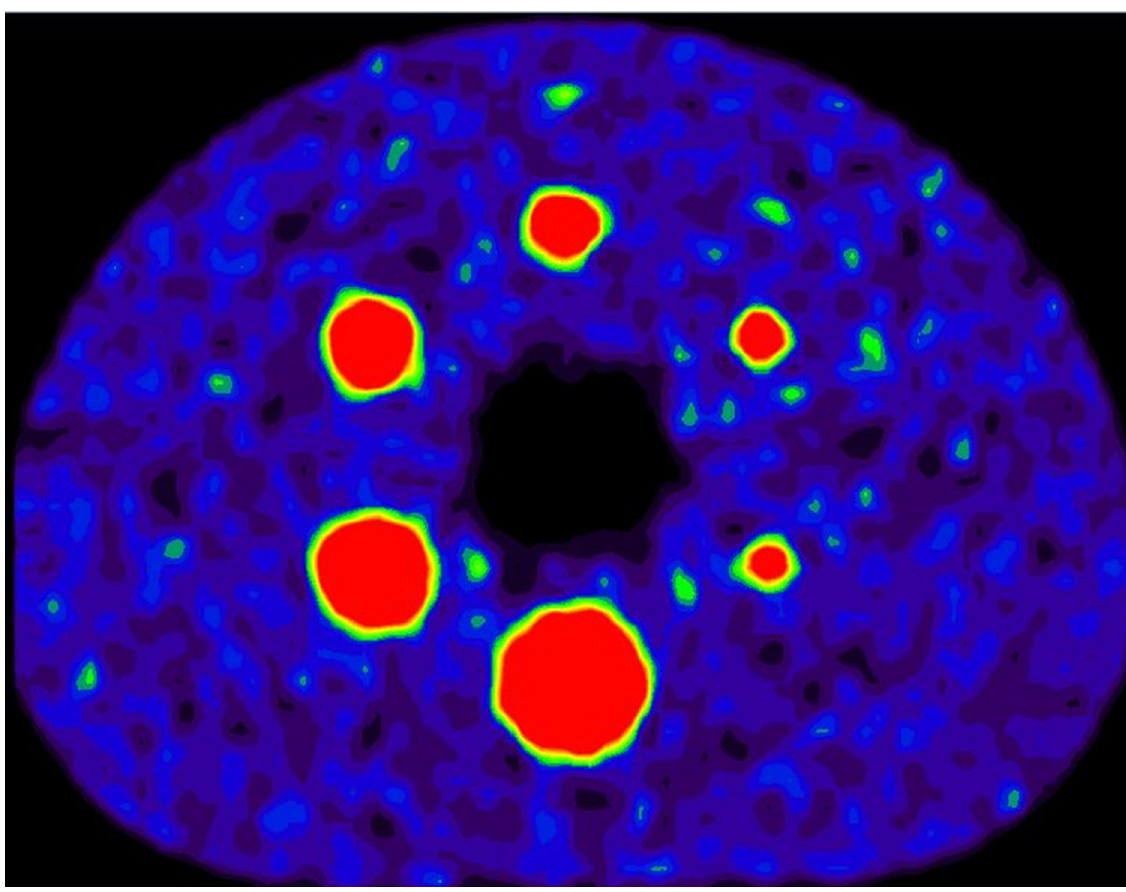
Fig 6. PET Scan of the NEMA image quality phantom. The image quality phantom contains six spheres with different diameters. For comparison, the spheres were segmented in the image and morphological features were calculated.